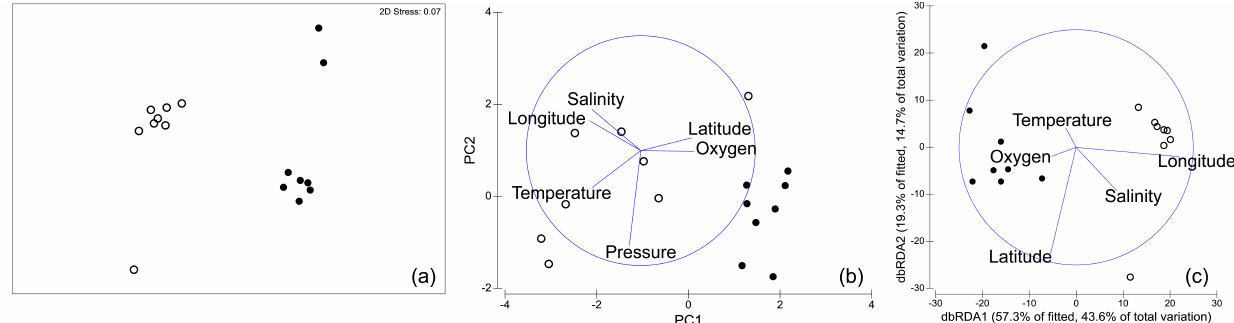
Fig. 4. Distribution of the bacterial communities in the Mediterranean Sea epipelagic waters according to biotic and environmental data. (a) Non-metric multidimensional scaling (NMDS) results based on qualitative ARISA fingerprinting illustrating a clear clustering of eastern (open circles) and western (filled circles) Mediterranean Sea epipelagic water. (b) Principal component analysis performed on the environ- mental data reported in Table S1 (Supplement). (c) dbRDA ordinations of the presence/absence of the ARISA dataset overlaid with the partial correlations of the tested environmental variables explaining the clustering of eastern (open circles) and western (filled circles) Mediterranean Sea epipelagic water.